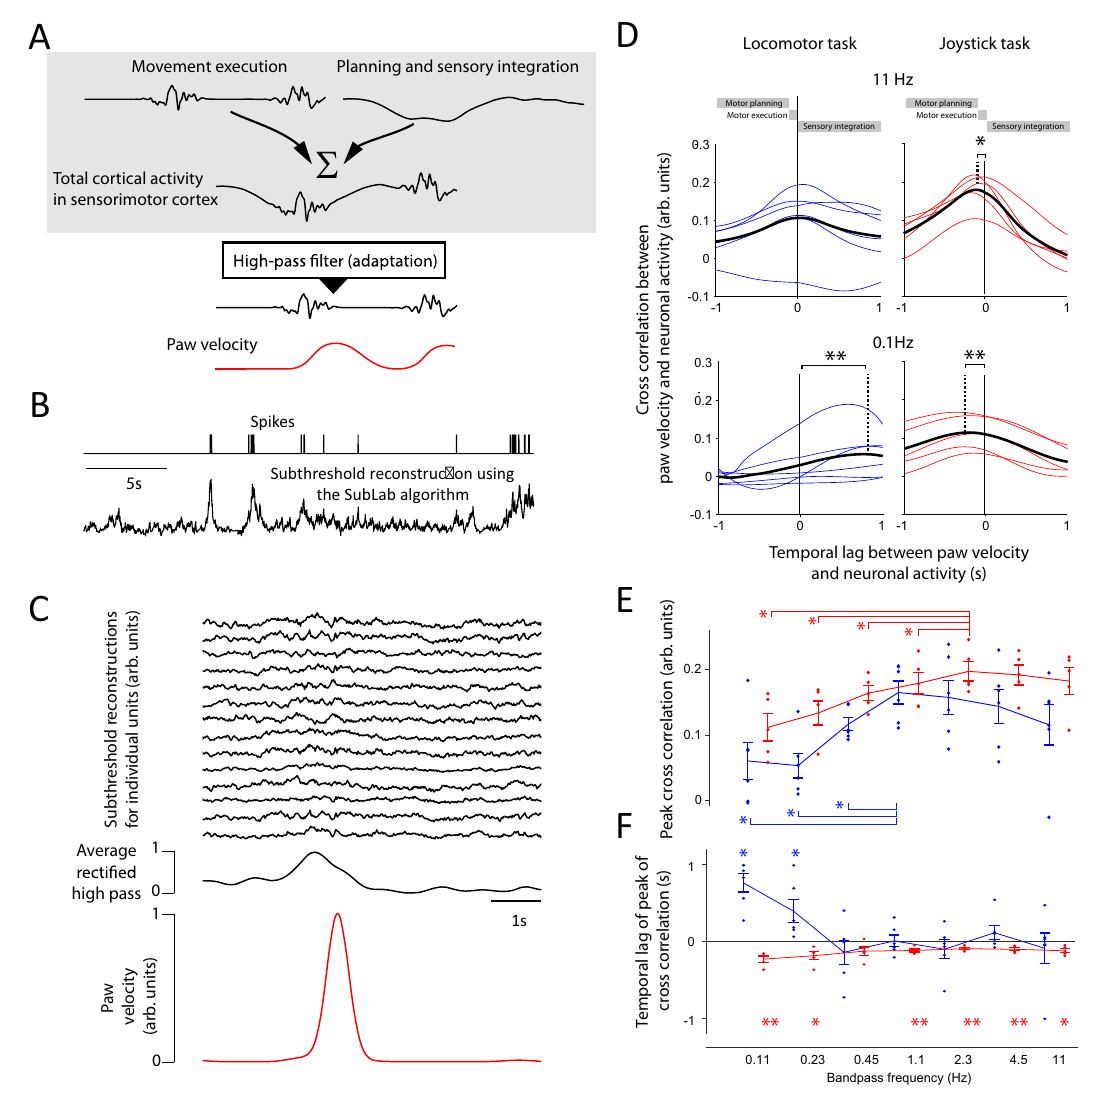
Fig. 4 High-pass- fi ltered neural activity is correlated to paw velocities. A Schematic illustration of how a high-frequency neuronal activity can be superimposed on a low-frequency neuronal activity and yet be separable. B Reconstruction of the subthreshold activity of the sorted units to enable the study of how fast neuronal activities change. C Reconstruction of neuronal activities from 14 randomly selected units during the joystick task (top). An increase in the average recti fi ed high-pass- fi ltered neuronal activity (black trace, middle row) typically precedes higher paw velocity (red trace). D The Pearson correlation coef fi cient for different lags between the recti fi ed band-pass (11 Hz)- fi ltered neuronal activity and the paw velocity during the locomotor task (upper-left, two-sided t -test, p = 0.7, n = 6), and the joystick task (upper right, two-sided t -test, p = 0.0115, n = 5), and for reciti fi ed band- pass (0.11 Hz)- fi ltered neuronal activity and the behavior during the locomotor task (lower left, two-sided t -test, p = 0.0013, n = 6), and the joystick task (lower right, two-sided t -test, p = 0.0051, n = 5). The comparison between cross-correlation values at time point zero and the time point of maximal cross- correlation reveals signi fi cant changes with different temporal lags. E The peak correlation between the paw velocity and the recti fi ed band-pass- fi ltered neuronal activity for seven frequencies for the joystick task (red), and the locomotor task (blue). Two-sided paired t -test against the peak at 1.1 Hz for the locomotor task: n = 6. p = 0.016 (0.11 Hz), 0.0029 (0.23 Hz), and 0.019 (0.45 Hz), and against the peak at 2.3 Hz for the joystick task: n = 5. p = 0.036 (0.11 Hz), 0.012 (0.23 Hz), 0.0085 (0.45 Hz), and 0.021 (1.1 Hz). No correction for multiple comparisons. Lines connecting the data points (denoting individual animals) across the frequencies denote the mean for the locomotor task (blue), and for the joystick task (red). Error bars denote the standard deviation of the mean. F Temporal lags of the peak Pearson correlation coef fi cient (across temporal lags) for recti fi ed band-pass- fi ltered neuronal activity. Two-sided paired t -test against the 0 s lag for the locomotor task: n = 6. p = 0.0013 (0.11 Hz), and 0.045 (0.23 Hz), and for the joystick task: n = 5. p = 0.0051 (0.11 Hz), 0.025 (0.23 Hz), 0.0056 (1.1 Hz), 0.005 (2.3 Hz), 0.0072 (4.5 Hz), and 0.012 (11 Hz). No correction for multiple comparisons. Lines connecting the data points (denoting individual animals) across the frequencies denote the mean for the locomotor task (blue), and for the joystick task (red). Error bars denote the standard deviation of the mean. Signi fi cances are indicated according to * p < 0.05, ** p < 0.01. Source data are provided as a Source Data fi